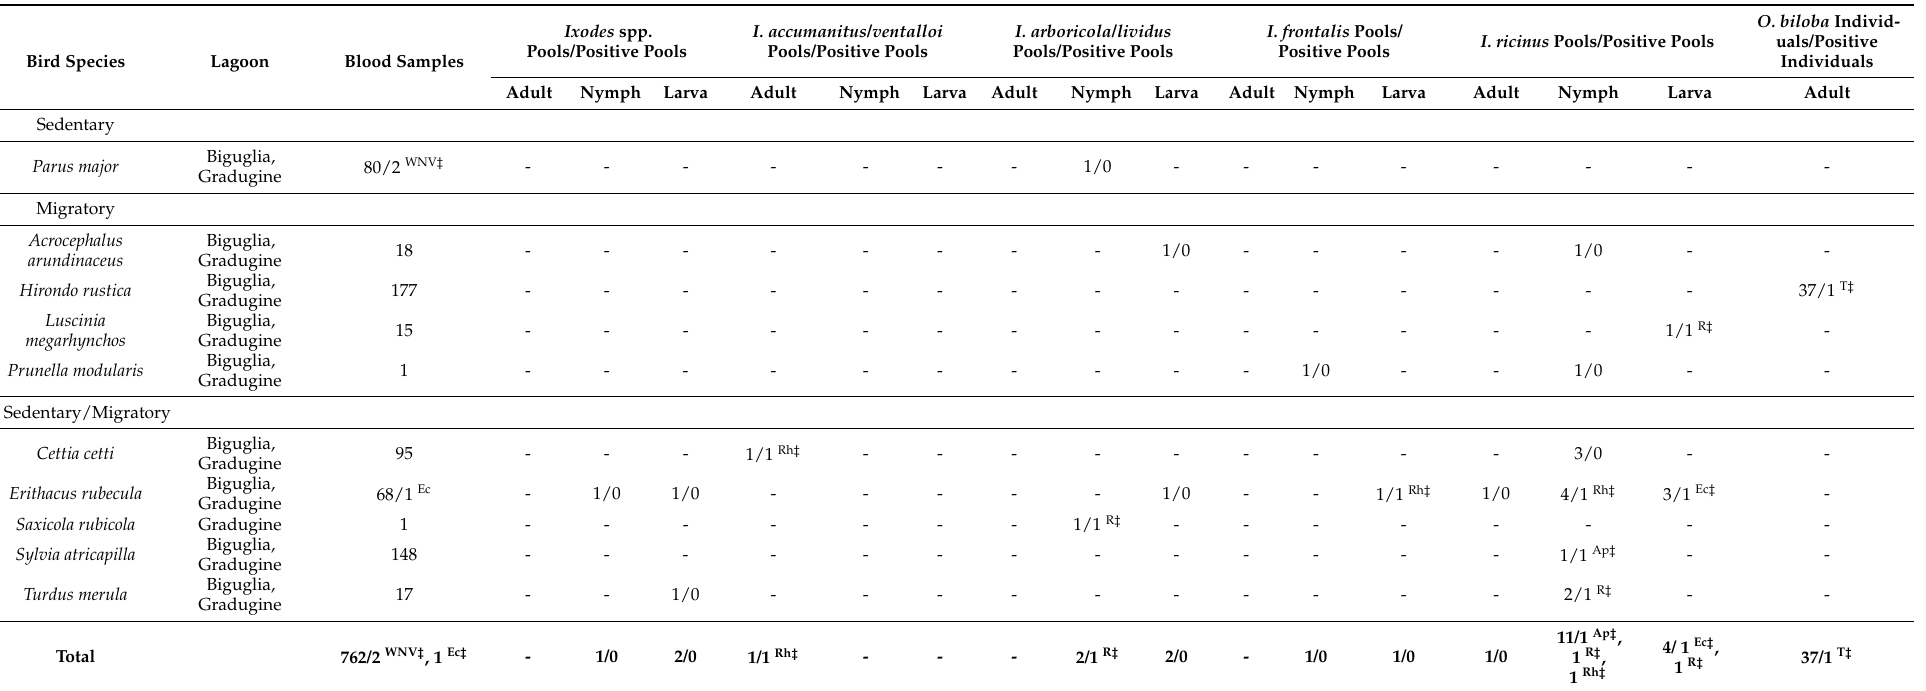
Table 3. Positive samples collected on birds in two Corsican lagoons. ‡ Ap: Anaplasma phagocytophilum , Ec: Ehrlichia chaffeensis , R: Rickettsia spp., Rh: Rickettsia helvetica , T: Trypanosoma spp. and WNV: West Nile